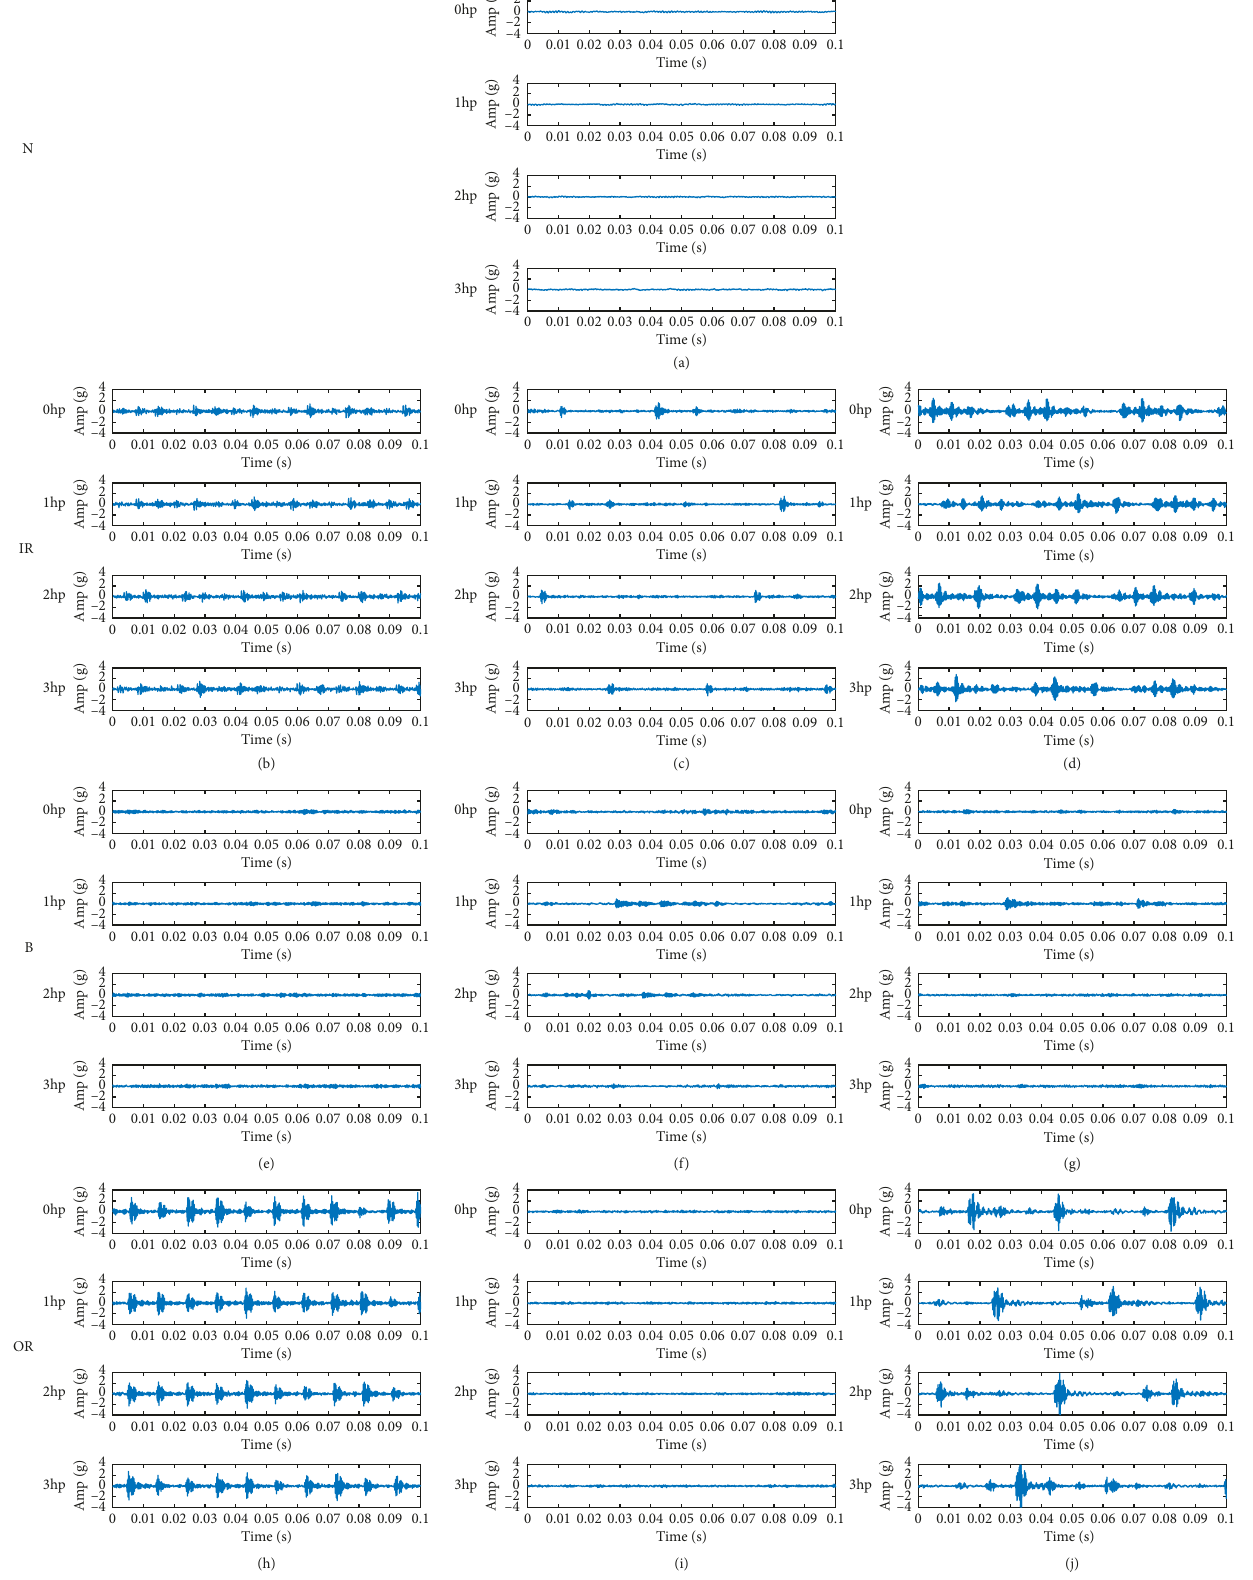
Figure 7: Vibration signals acquired from ten states of rolling bearing in CWRU: (a) N, (b) IR7, (c) IR14, (d) IR21, (e) B7, (f) B14, (g) B21, (h) OR7, (i) OR14, and (j)